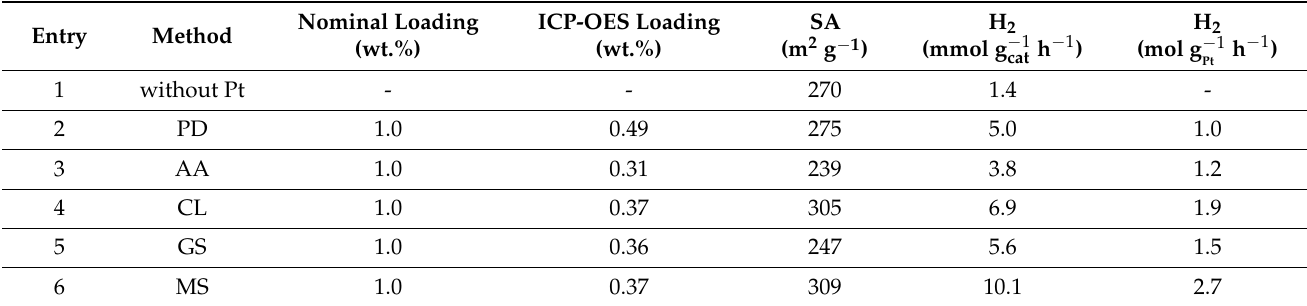
Table 2. Hydrogen productivity ( ± 10%) for as-prepared Pt@PC500 photocatalysts (T = 30 ◦ C, c Pt@PC500 = 0.5 g L − 1 , 300 W Xe lamp (full spectrum), and 10 vol.%